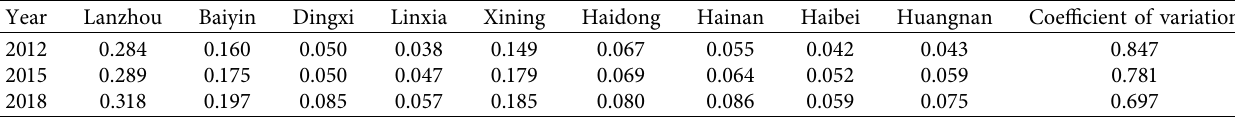
Table 3: The high-quality development index of cities, 2012–2018.